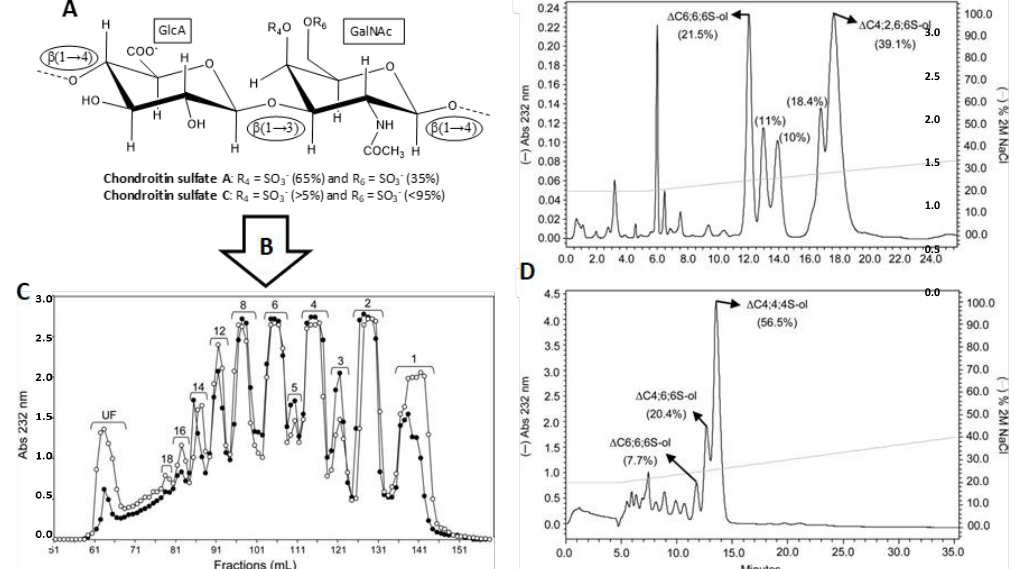
Figure 8. General scheme for production of GAG oligosaccharides of defined size and structures, exemplified by the various hexasaccharides of chondroitin sulfates A and C. ( A ) Structural representation of the chondroitin sulfate A and C. GlcA and GalNAc stand for glucuronic acid and N -acetylgalactosamine, respectively. Glycosidic linkages are depicted inside the ellipses. ( B ) After a 2-day digestion of chondroitin sulfate A derived from bovine trachea (btCS-A) or chondroitin sulfate C derived from shark cartilage (scCS-C) with a commercial preparation of chondroitinase C from Flavobacterium heparinum , the resultant mixture of fragments were applied in a SEC Bio-Gel P-10 column ( C ) for oligosaccharide fractionation (open circles for scCS-C and filled circles for btCS-A). Then, the pool of hexasaccharides was applied to a HPLC-SAX column for fractionation of isomers. ( D ) Both mixtures of hexasaccharides were obtained from peak 6 of their respective Bio-Gel P-10